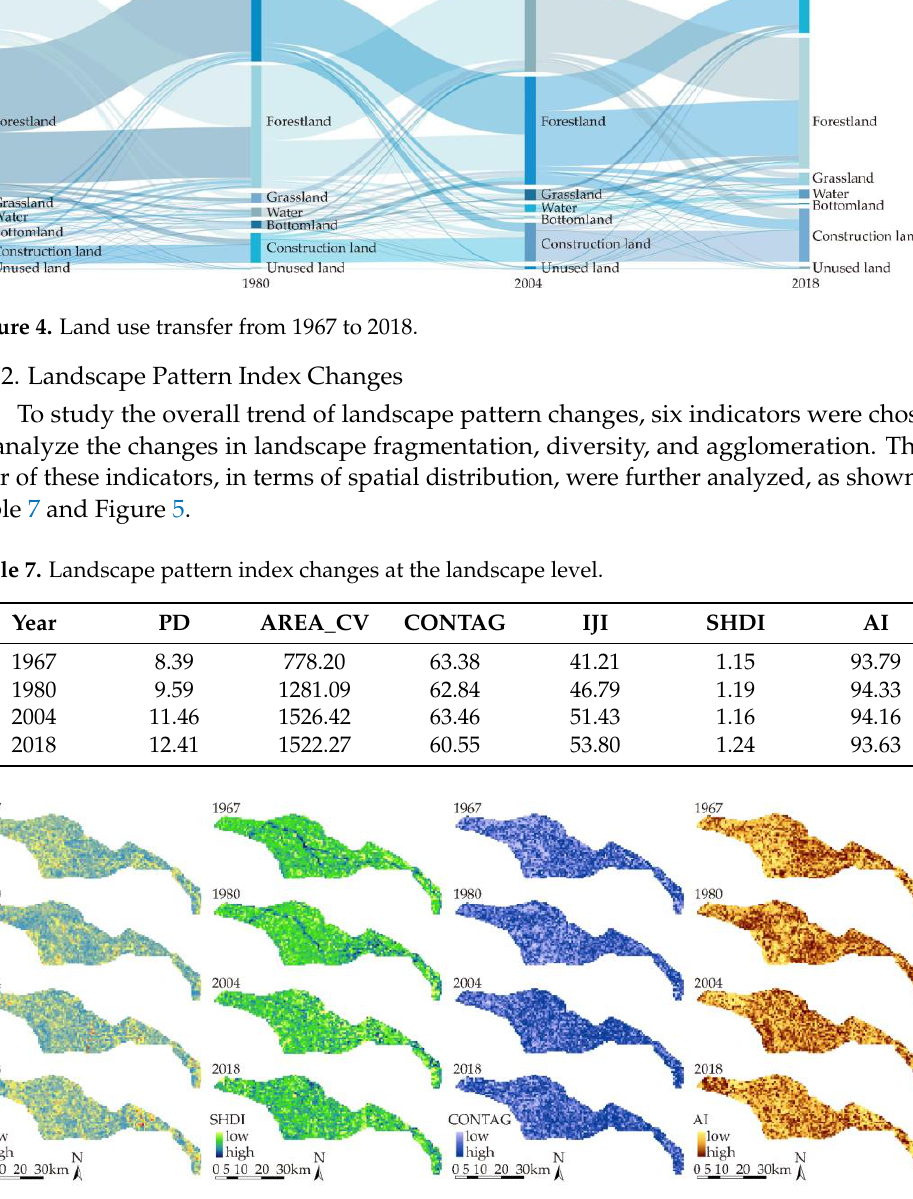
Figure 3. Land use changes from 1967 to 2018 (km 2 ).